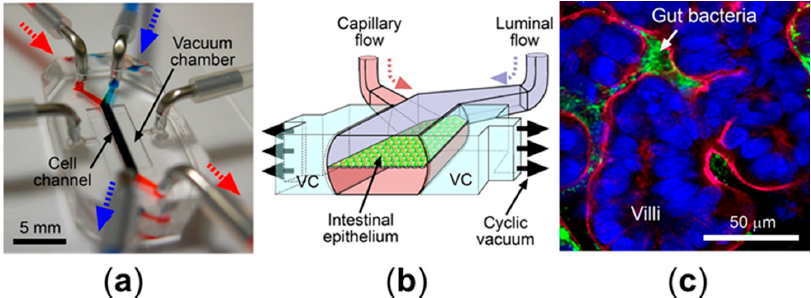
Figure 3. An organomimetic human gut-on-a-chip microphysiological system: ( a ) a photographic image of a gut-on-a-chip microdevice. Arrows indicate the direction of flow in the microchannels (blue, luminal flow; red, capillary flow); ( b ) a schematic of a gut-on-a-chip displaying the flexible nature to exert peristalsis-like, vacuum-driven mechanical deformations. VC, vacuum chamber; and ( c ) an overlaid confocal immunofluorescence image showing a horizontal cross-section view of intestinal villi co-cultured with GFP E. coli (green). Brush border membrane (F-actin, red) and nuclei (DAPI, blue) are fluorescently highlighted.